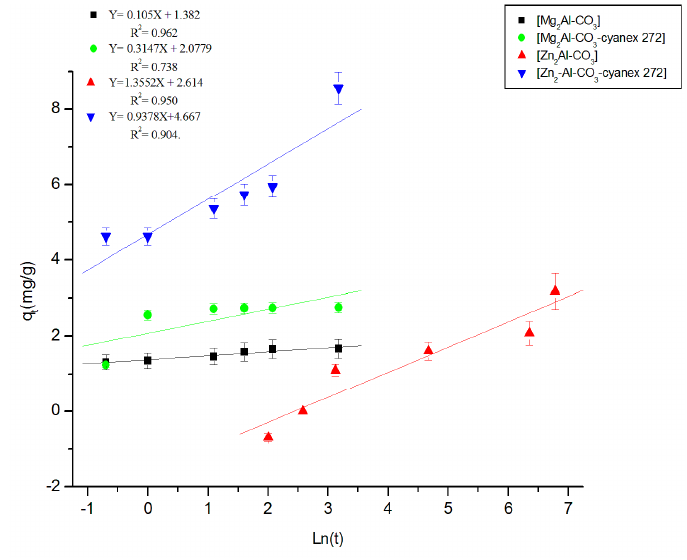
Figure 8. Elovich model of Zn (II) extraction by different materials.